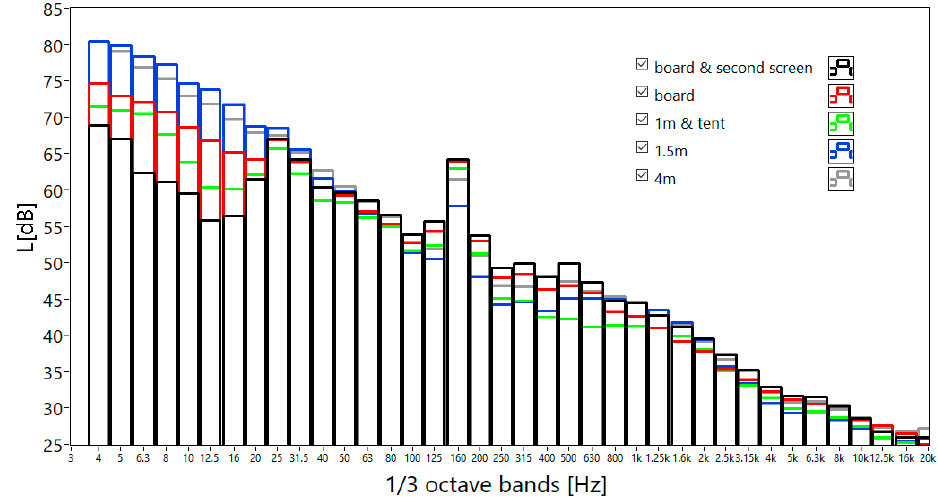
Figure 10. Ventilation shaft noise. One-third octave spectrum—average wind speed 6.5 m/s.